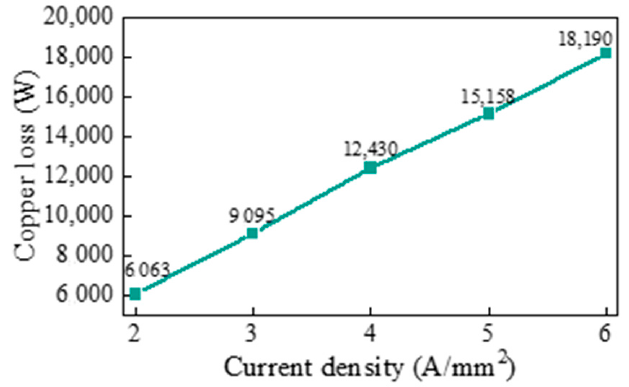
Figure 11. Copper loss under different current densities.